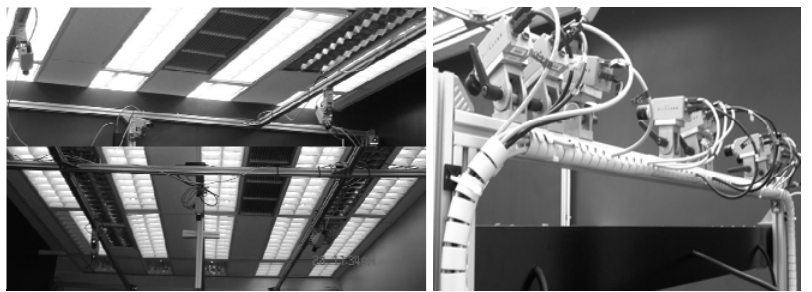
Figure 1. Distribution of cameras in the VISION